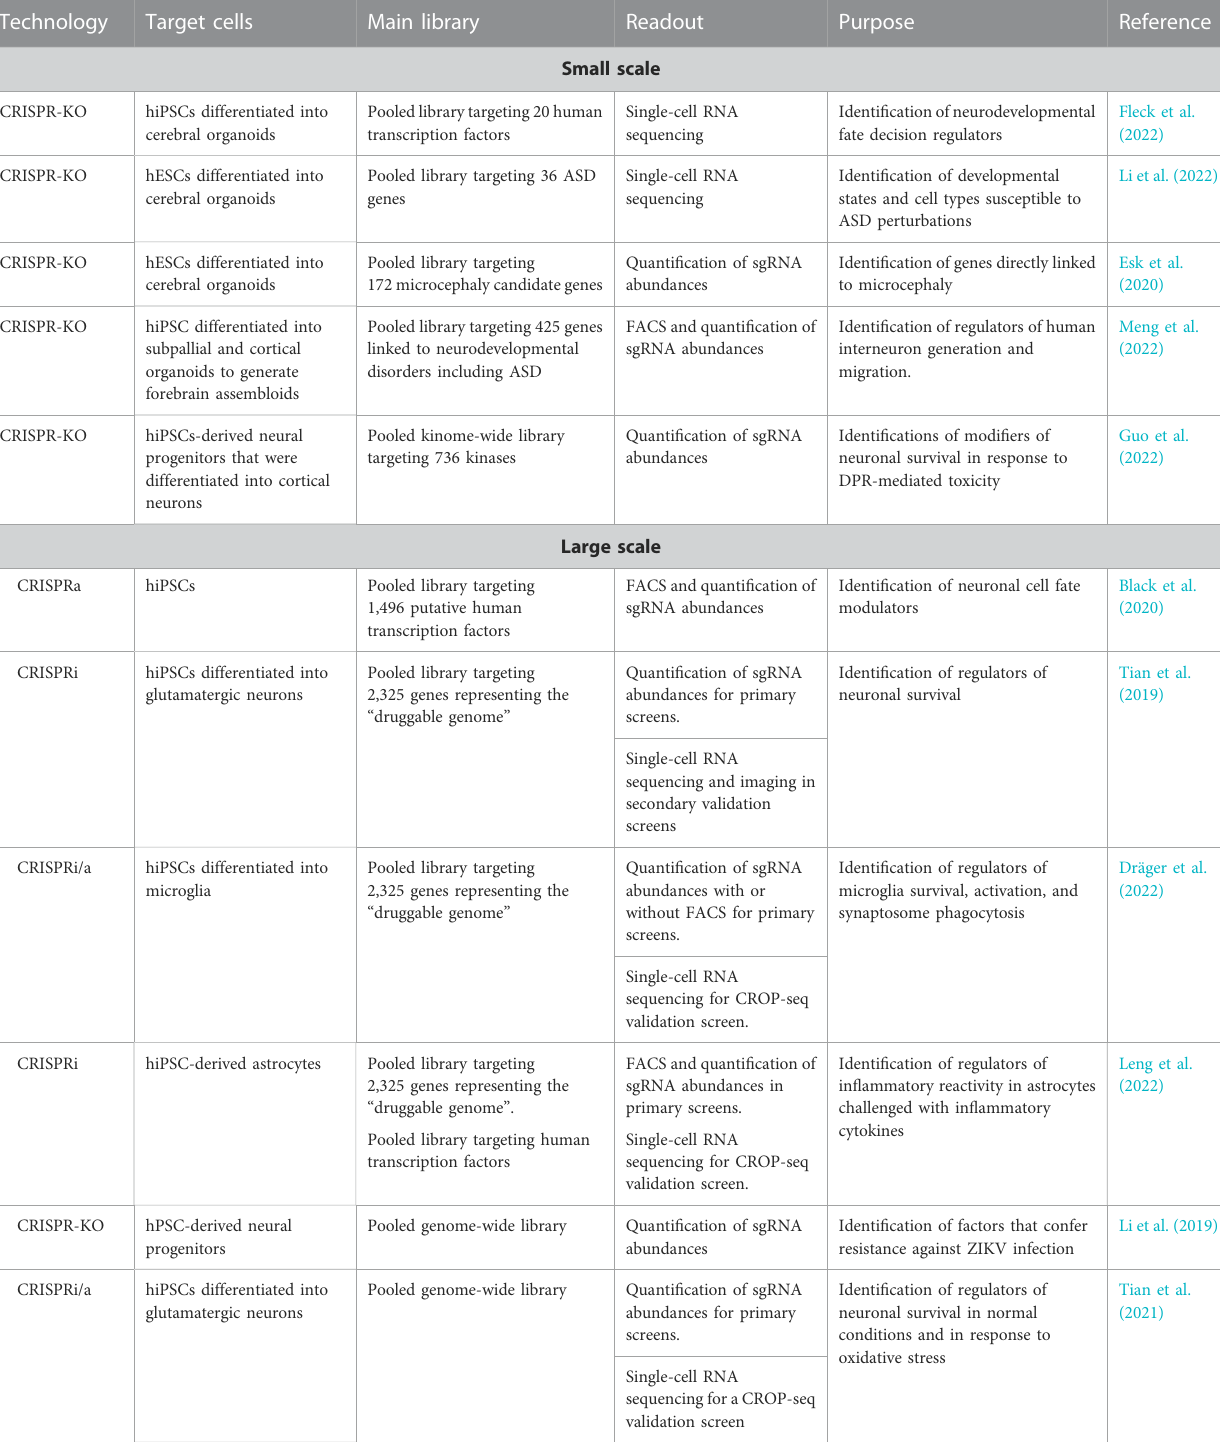
TABLE 1 Small and large-scale CRISPR screens that utilized hPSC-derived cultures to understand neurodevelopment and